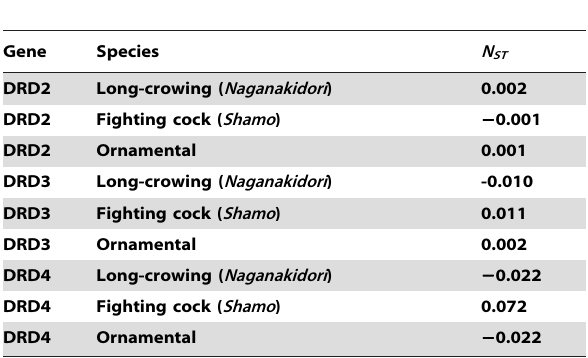
Table 2. N ST for the three dopamine receptor genes among three chicken